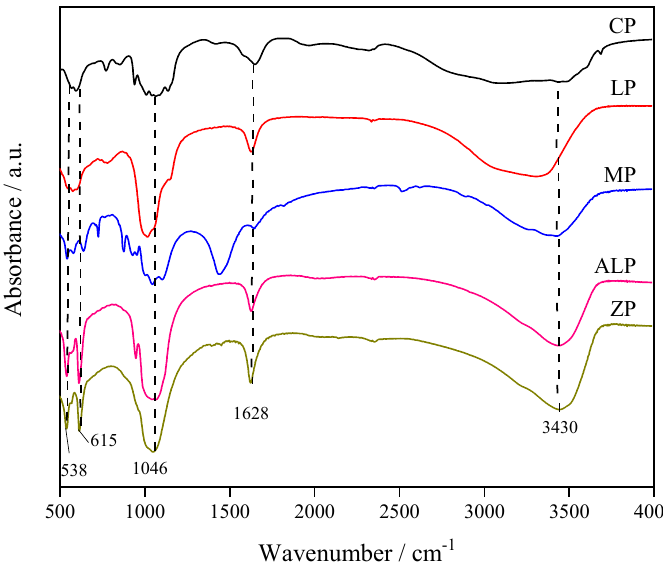
Figure 2. FT-IR spectra of different metal phosphate catalysts.